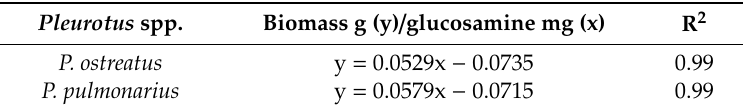
Table 1. Linear regression equations of glucosamine (mg) and mycelial biomass (g) of Pleurotus strains grown on grape pomace